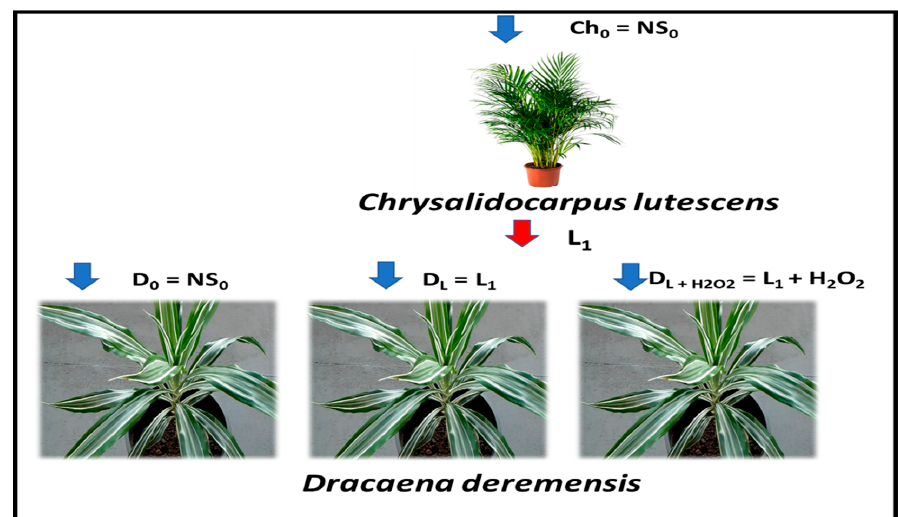
Figure 1. Schematic overview of the experimental design.